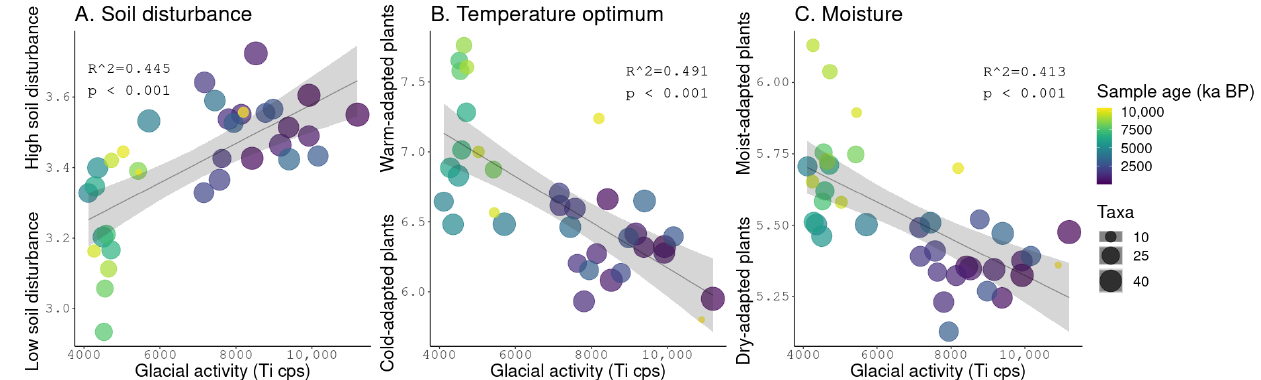
Figure 4. Linear regression of glacial activity and ( A ) soil disturbance, ( B ) temperature optimum, and ( C ) moisture trait values based on plants identified in the sed aDNA combined with plant trait values reported in [21]. The number of plant taxa used to calculate the weighted average is shown as point size while sample age is represented as a color scale. Note that temperature optimum index values are inverted from those reported in [21].